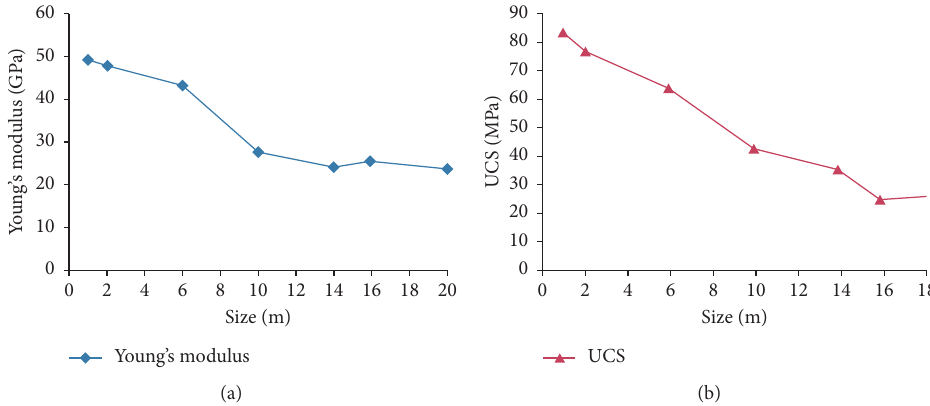
Figure 14: Scale effect analysis of different strength parameters: (a) Young’s modulus; (b) UCS.